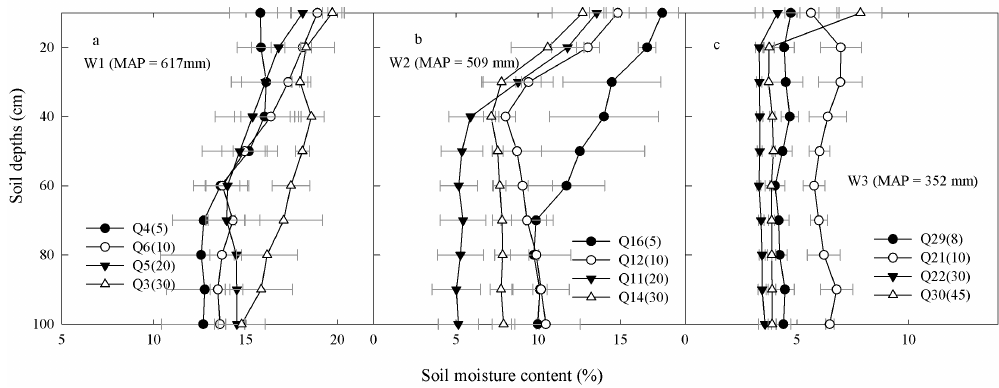
Fig. 5. Soil moisture profiles for watersheds (a) W1, (b) W2 and (c) W3. The bars indicate the standard deviations of the means ( N = 3). In the legends, the numbers in the parentheses after W1, W2 and W3 indicate stand ages.